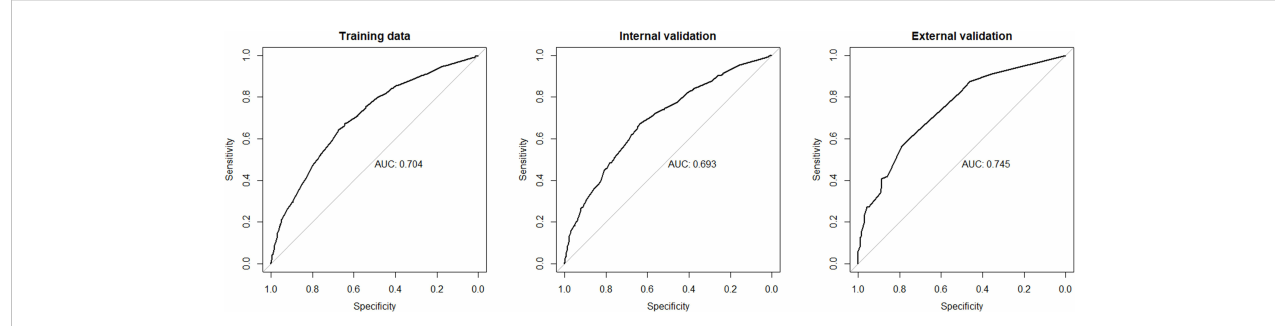
FIGURE 3 The receiver operating characteristics (ROC) curve and area under the ROC curve (AUC) in the training cohort, internal cohort, and external cohort. CLNM, central lymph node metastasis.